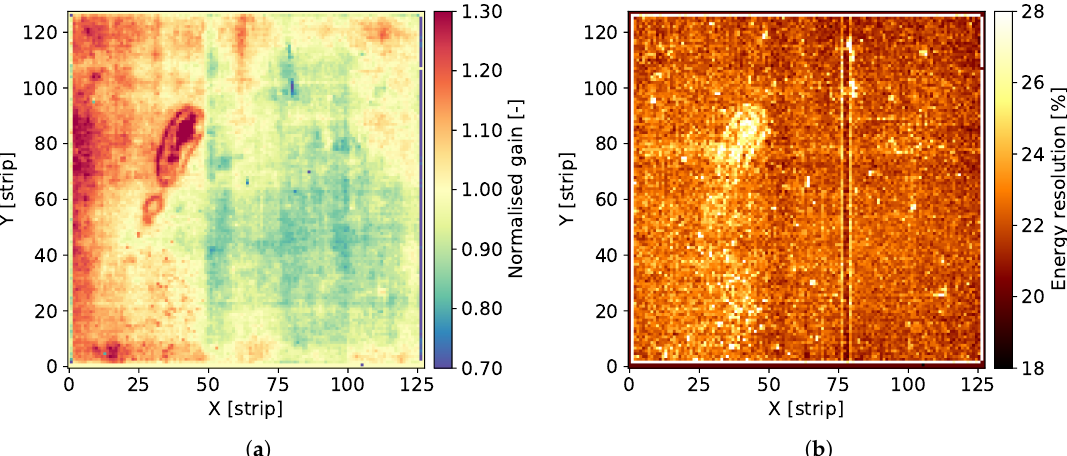
Figure 12. GEM detector C 2 . 2D maps of: ( a ) normalized gas gain; and ( b ) energy resolution for detector bias voltage of 3840V.